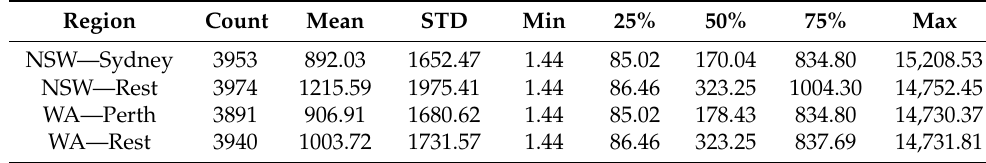
Table 3. A summary of statistics of the total costs of home isolation for households with a size greater than one 2